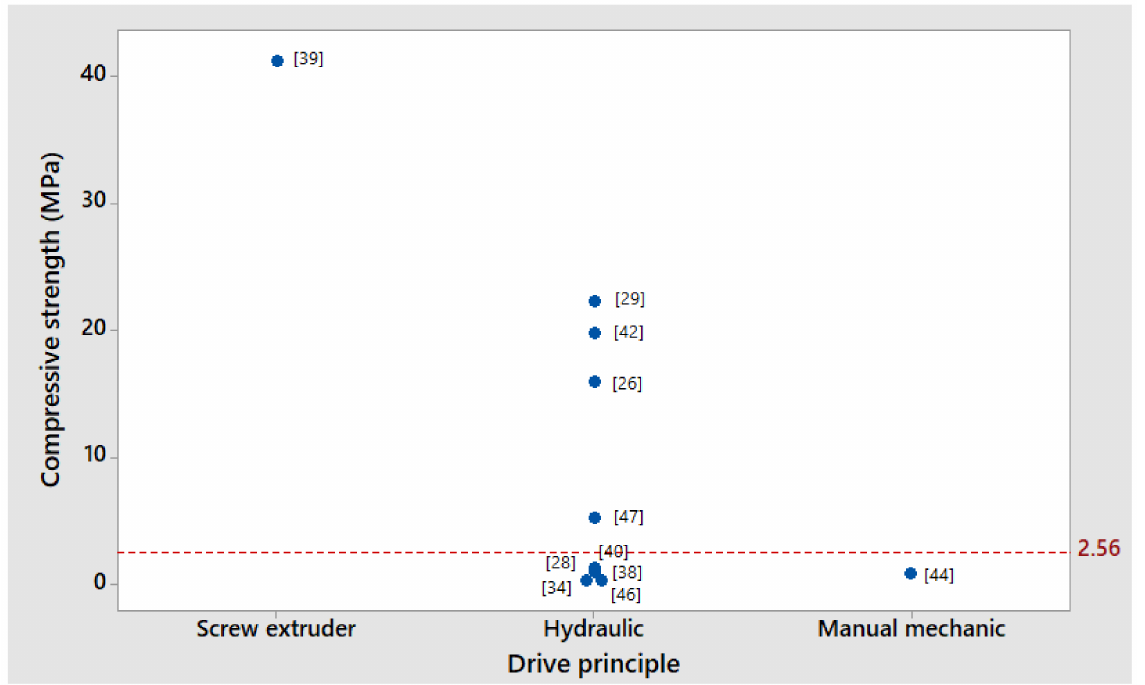
Figure 9. Relationship between the individual values of compressive strength (MPa) with the principle of operation of briquetting